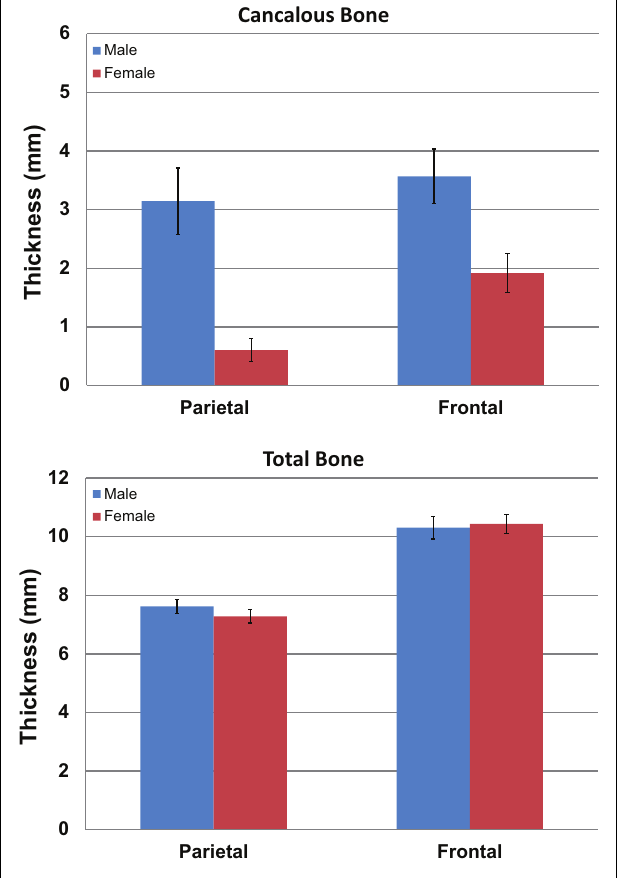
FIGURE 7 |The graphs show the mean measurements in millimeters of the cancelous bone in the parietal and frontal regions by gender (blue male red female) .The upper graph is for cancelous bone thickness and the lower graph is total bone thickness. Error bars represent ± standard error of the